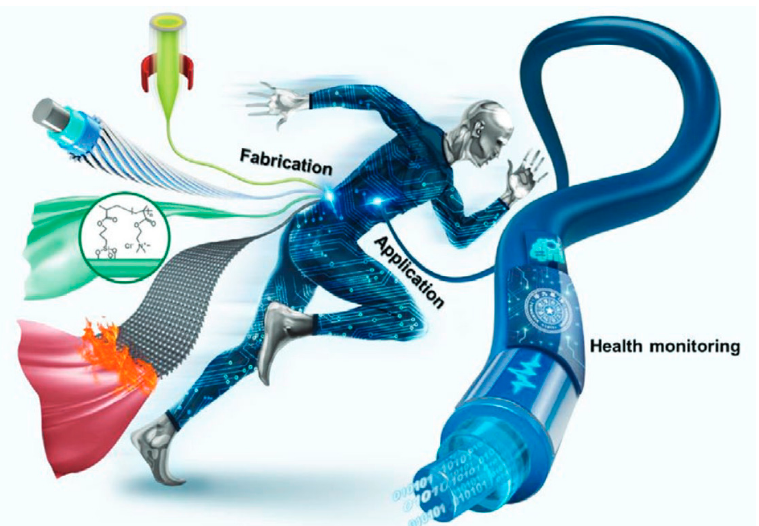
Figure 15. Health monitoring scheme using electronic fibers/textiles and the respective applications. Images were taken with kind permission from [110].